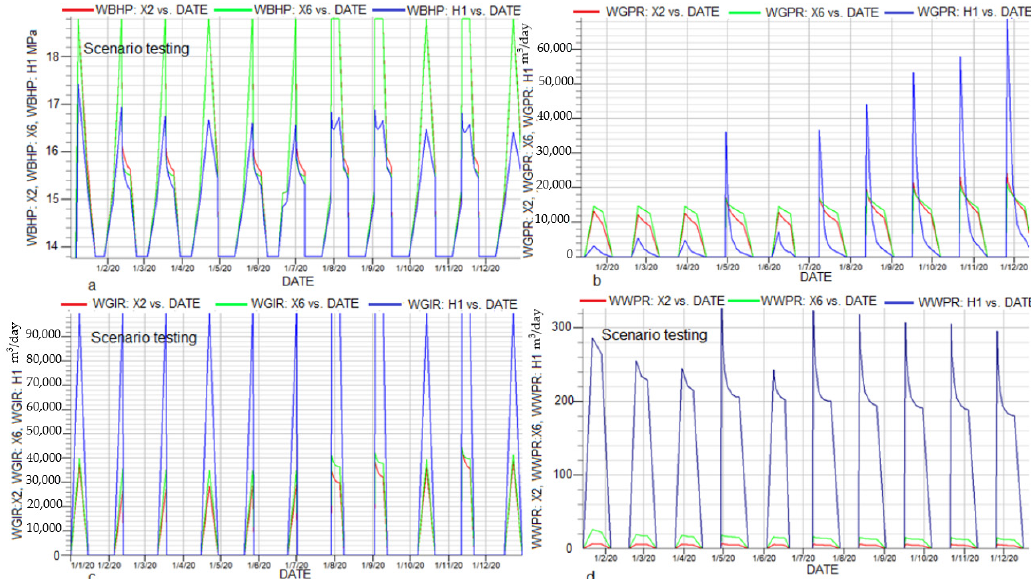
Figure 6. Well properties comparison of the three-well case scenario with short-term schedule 1wkInj-1wkShut-2wkProd-1wkShut 1 year. X2 and X6 are vertical wells, and H1 is the horizontal well: ( a ) well bo tt om hole pressure (WBHP) of all wells; ( b ) production gas rate (WGPR) for all three wells; ( c ) injection gas rate (WGIR) for all three wells and; ( d ) well water production rate (WWPR) for all the wells.